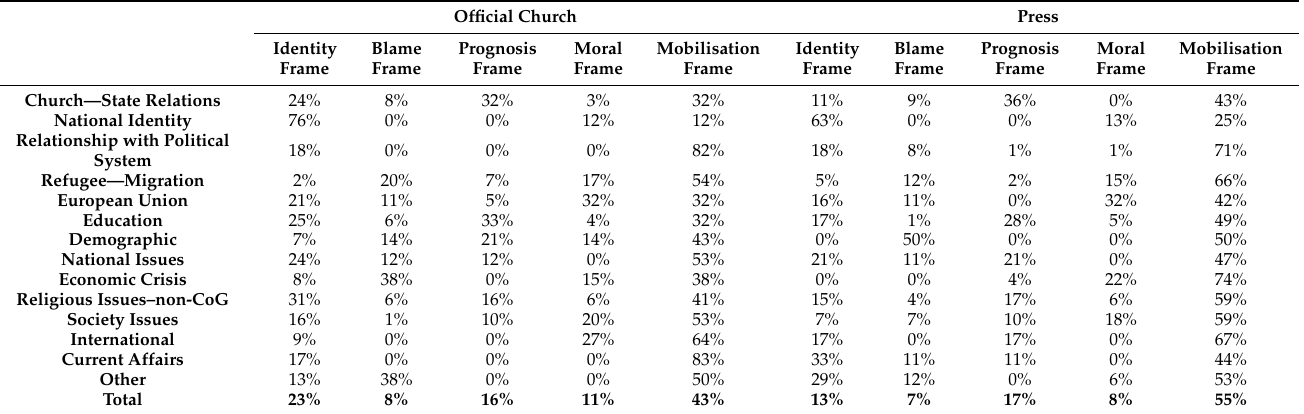
Table 1. Framing per main thematic